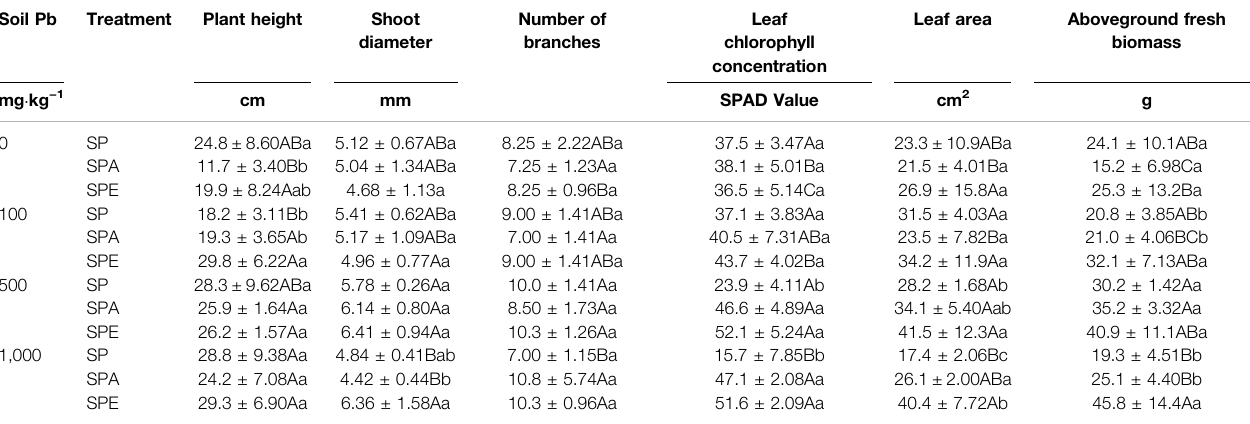
TABLE 3 | Effects of the two earthworms species, Amynthas aspergillum and Eisenia fetida , on the growth of Brassica campestris . Soil Pb